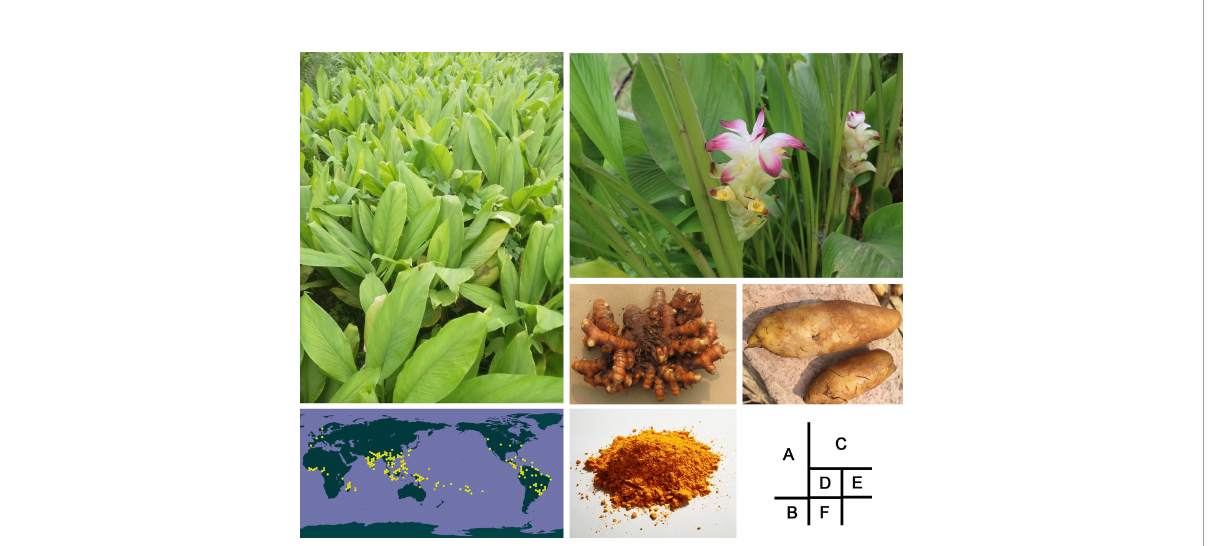
FIGURE 1 Morphological traits of Curcuma longa. (A) image of C longa . (B) global distribution range of C longa , which was obtained from the GBIF website (www.gbif.org). (C) a photographs of C longa fl owers, (D) rhizomes, (E) tubers, (F) turmeric